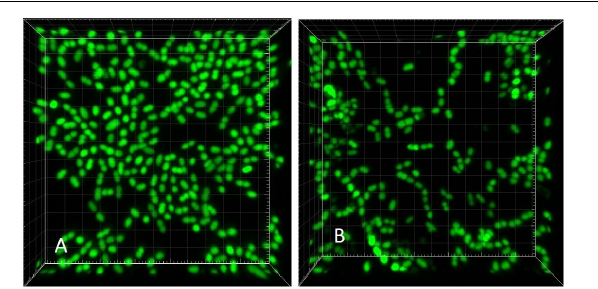
FIGURE 8 | CLSM (Syto 9) 3-dimensional rendering of E. faecalis biofilms at two different dilution rates ( D ). (A) D = 0.28 h − 1 and (B) D = 0.81 h − 1 (same CLSM file as Figure 3C ). Side of the square base of image 25.4 µ